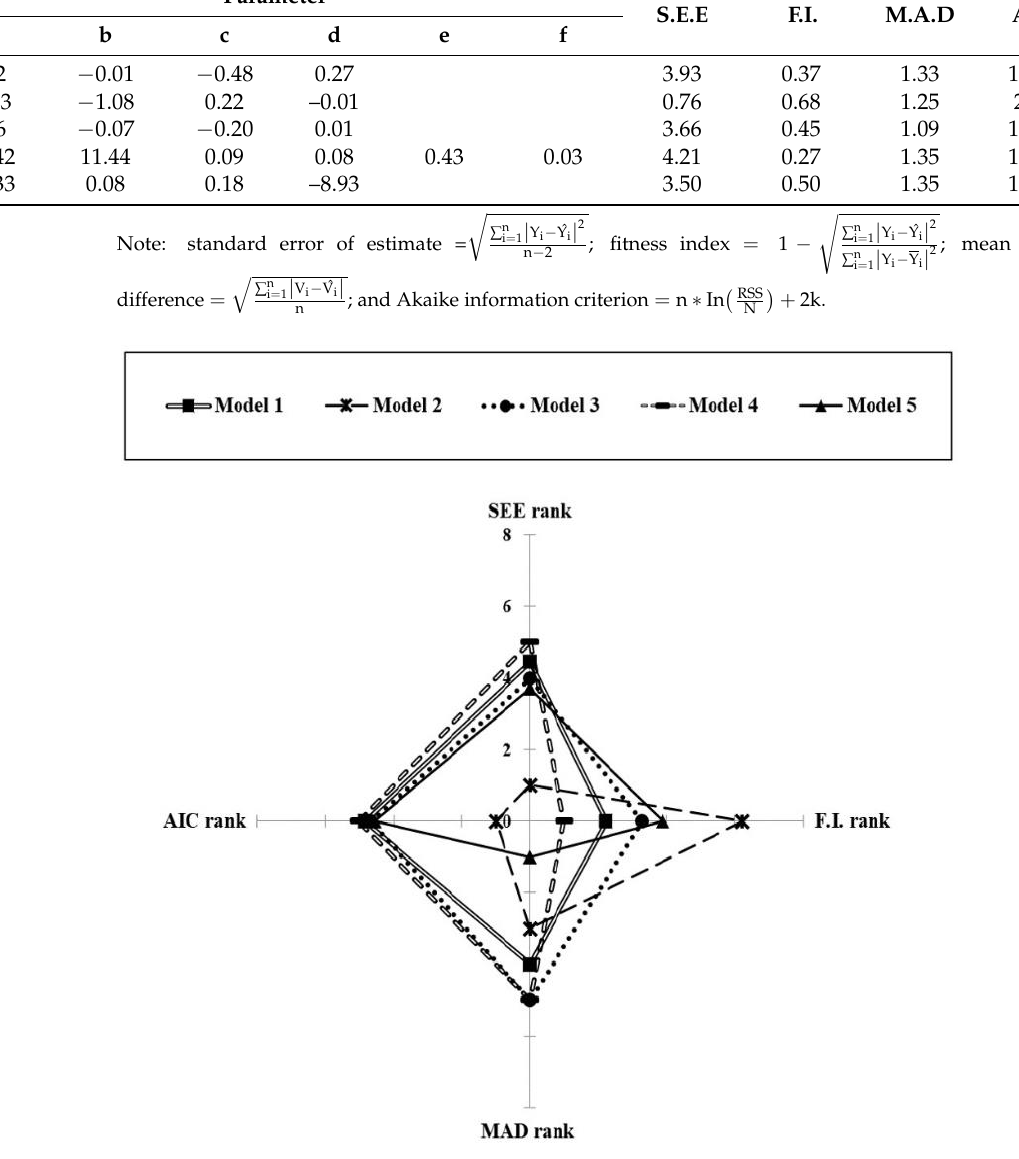
Figure 3. Rank analysis of the simple volume models using the validation dataset (note: the model with the smallest area inside the box represents the best model). AIC: Akaike information criterion; SEE: standard error of estimate; F.I.: fit index; and MAD: mean absolute difference.